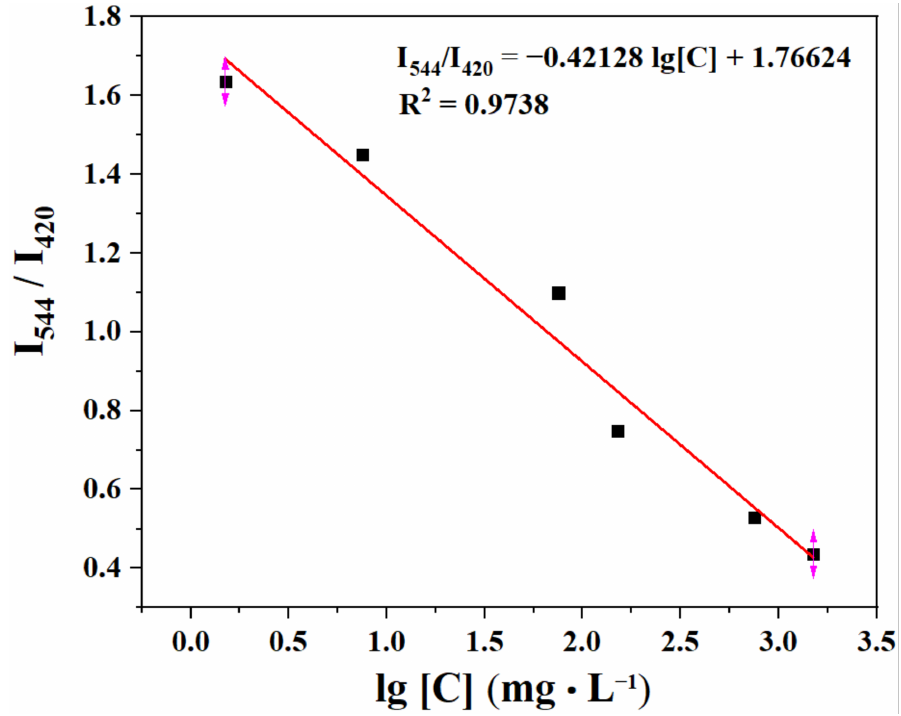
Figure 7. The plot of I 544 /I 420 vs. the TDGA